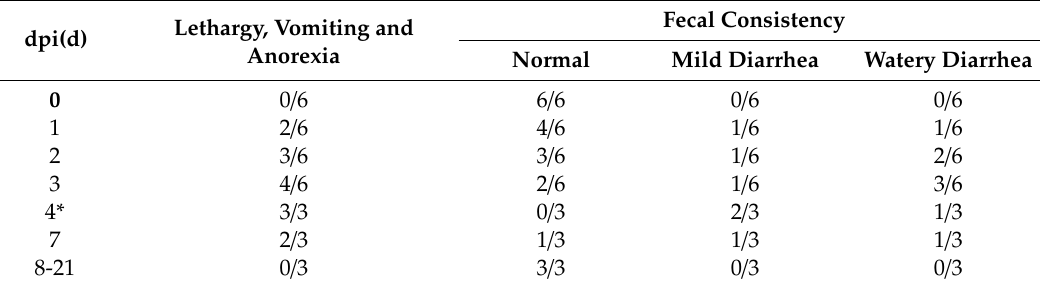
Table 1. Clinical observation records of five-day-old pigs challenged with PDCoV.